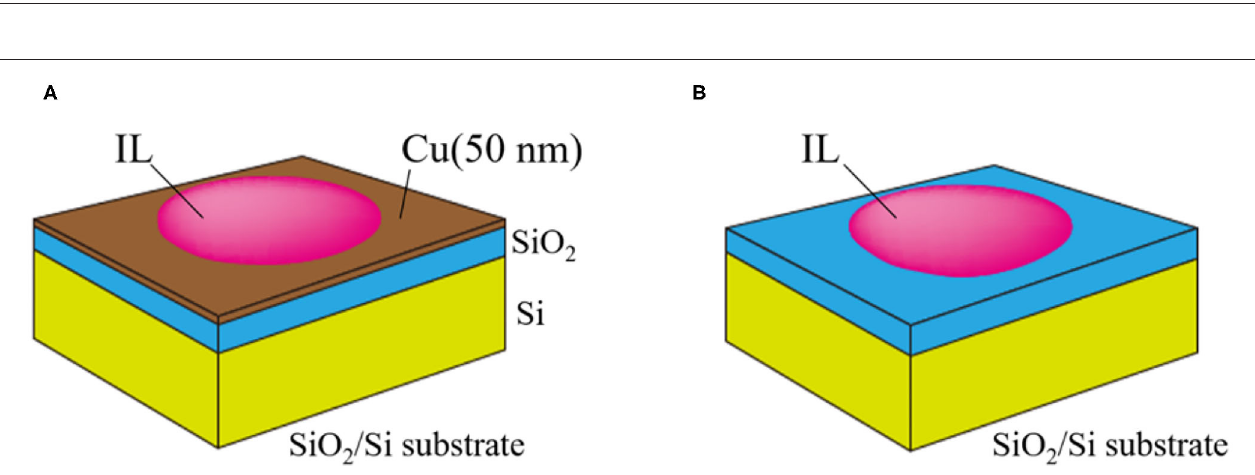
FIGURE 4 | Schematic illustrations of (A) IL/Cu and (B) IL/SiO 2 used for XPS measurements. The size of the substrate and IL drop (roughly 5mm in diameter) is much larger than the detection area of the XPS instrument (100 µ m in diameter).